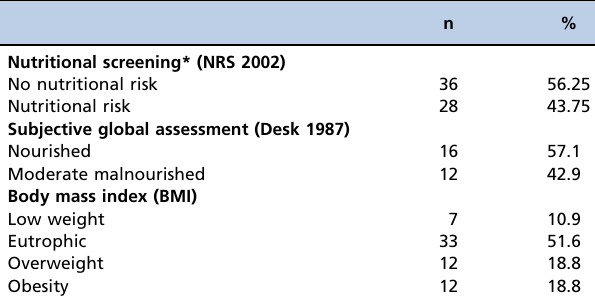
Table 2 - Nutritional characteristics of the patients.